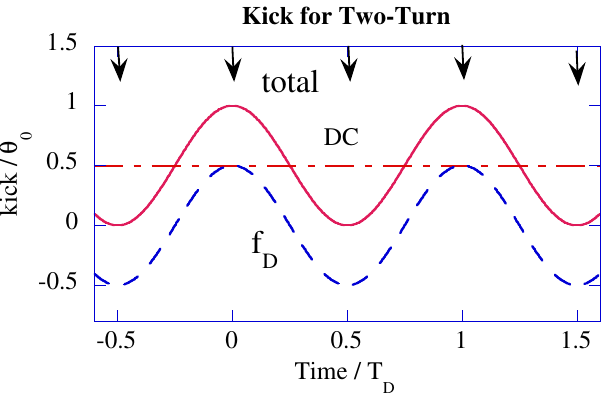
FIG. 1. (Color) Required deflection for two-turn system. Deflection of the system (solid), cavity with frequency of f (dashed), and two DC magnets (dot-dashed) are shown. Timing of bunch passages into the system is at every T